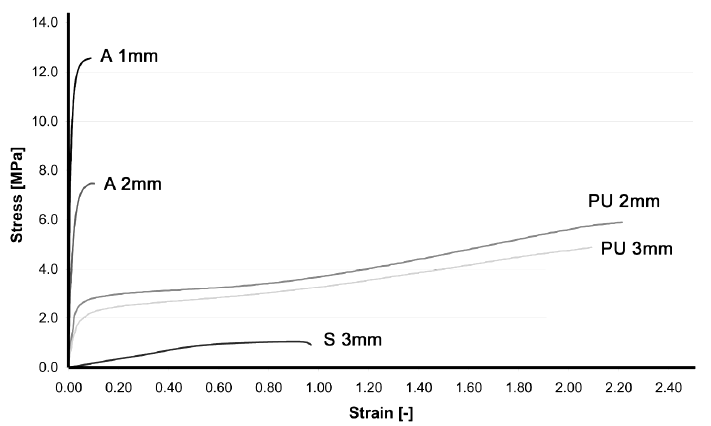
Figure 6: Stress-strain diagrams of the glued connections subjected to tension (S- silicone, A- acrylic, PU- Polyurethane booster